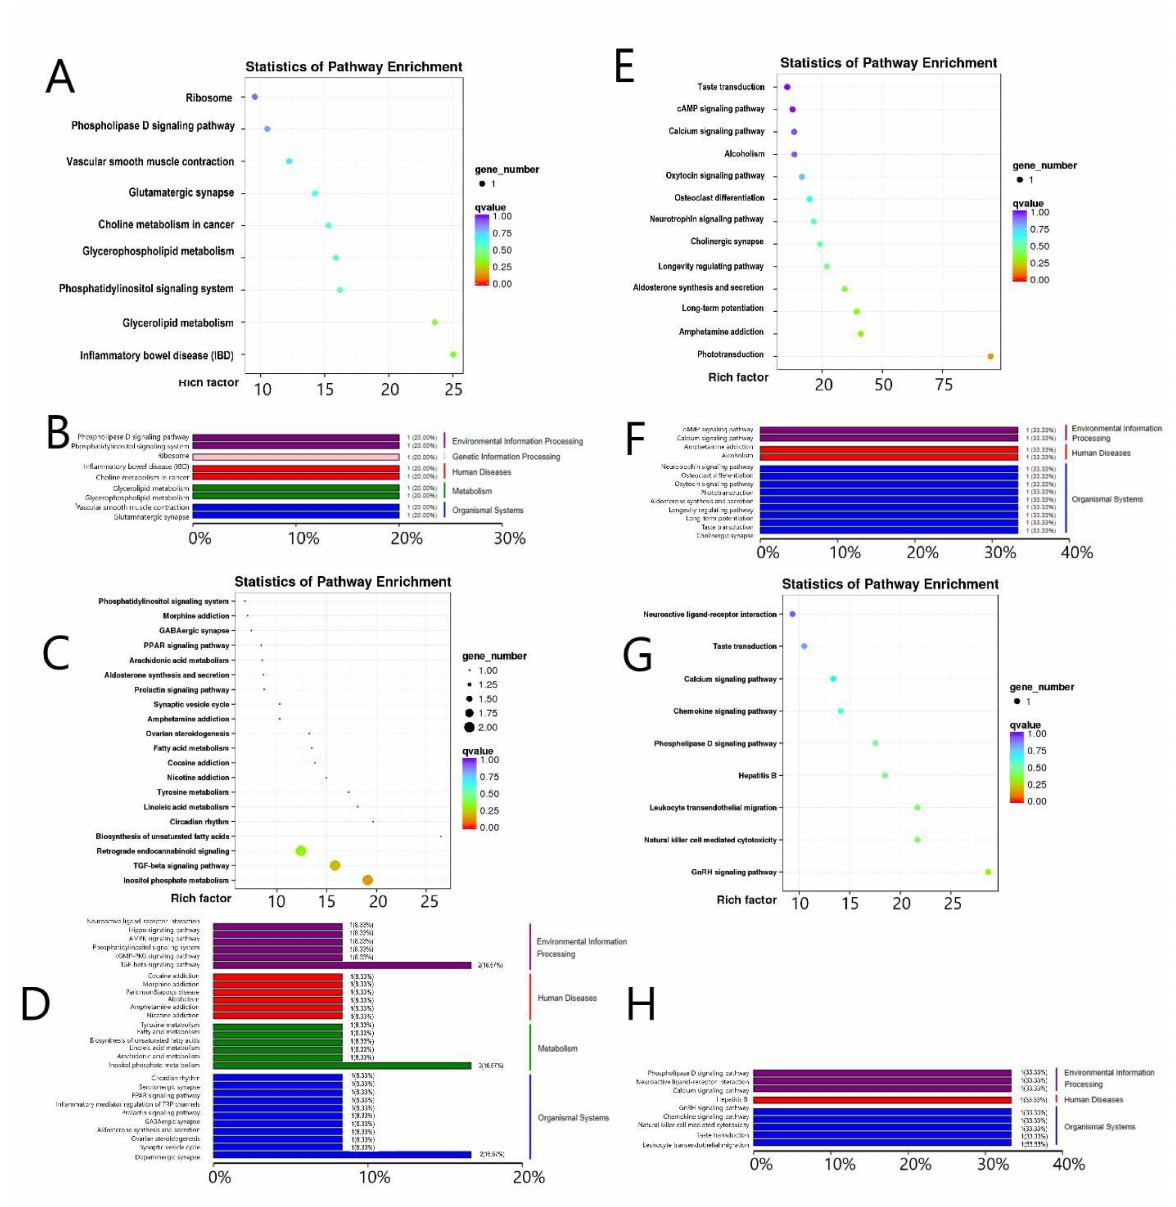
Figure 4. KEGG enrichment level of DEGs in the pituitary gland and hypothalamus at 18 and 30 months of age as compared with those at 6 months of age: ( A , B ) Pituitary gland at 18 months of age cas ompared with those at 6 months of age; ( C , D ) hypothalamus at 18 months of age as compared with those at 6 months of age; ( E , F ) pituitary gland at 30 months of age as compared with those at 6 months of age; ( G , H ) hypothalamus at 30 months of age as compared with those at 6 months of